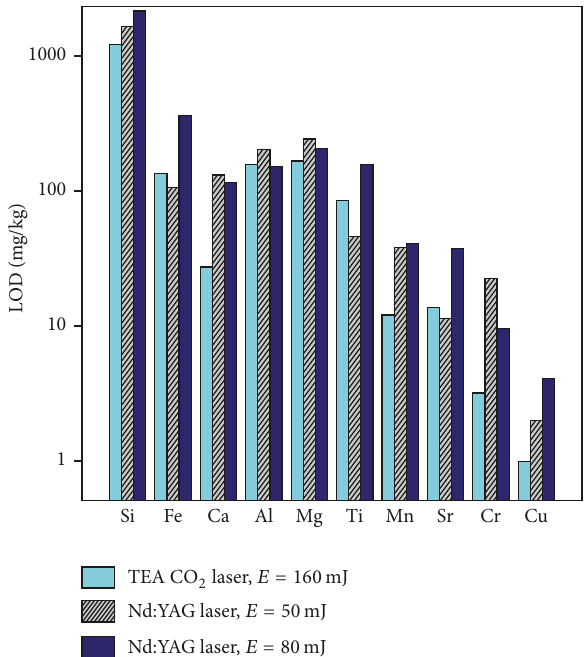
Figure 6: Comparison of estimated limits of detection obtained for TEA CO 2 and Nd:YAG laser-induced plasma over basalt sample in air at atmospheric